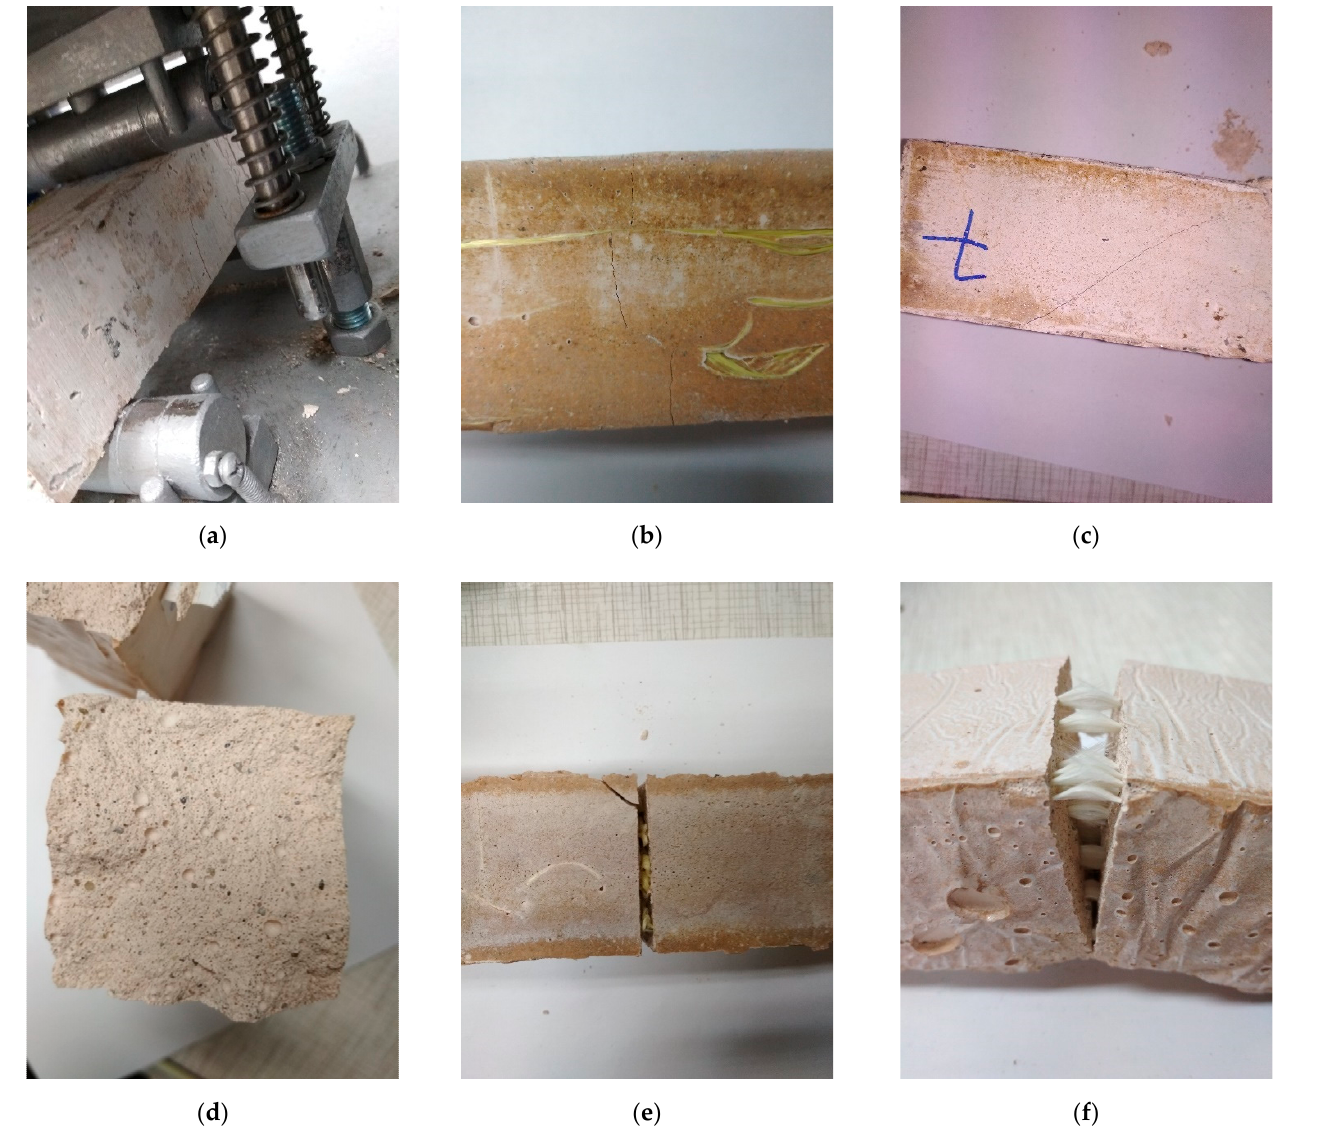
Figure 12. Study of the fracture behavior. ( a ) Sample during the bending test. ( b ) Sample after the bending test—typical mechanism of cracking propagation (in the middle of the sample). ( c ) Sample after the bending test—first crack appears in the middle, and the second crack appears near the edge. ( d ) Sample after the bending test—brittle behavior of the sample without reinforcement. ( e ) Sample after the bending test—more ductile behavior of the sample with aramid fibers. ( f ) Sample after the bending test—more ductile behavior of the sample with glass fibers.